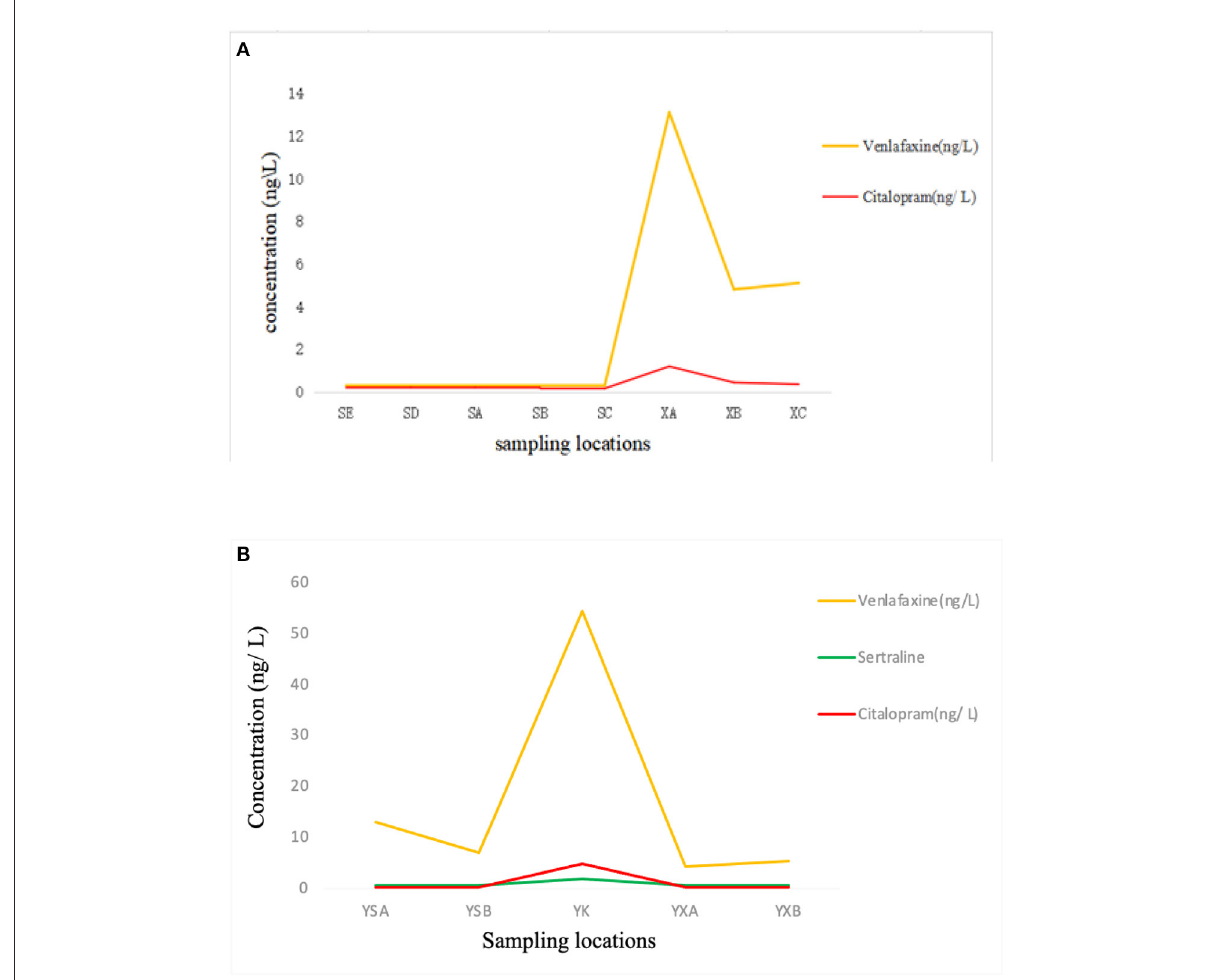
FIGURE3 (A) Concentration of antidepressant drugs in Qiantang River. (B) Concentration of antidepressant drugs in Yuhangtang